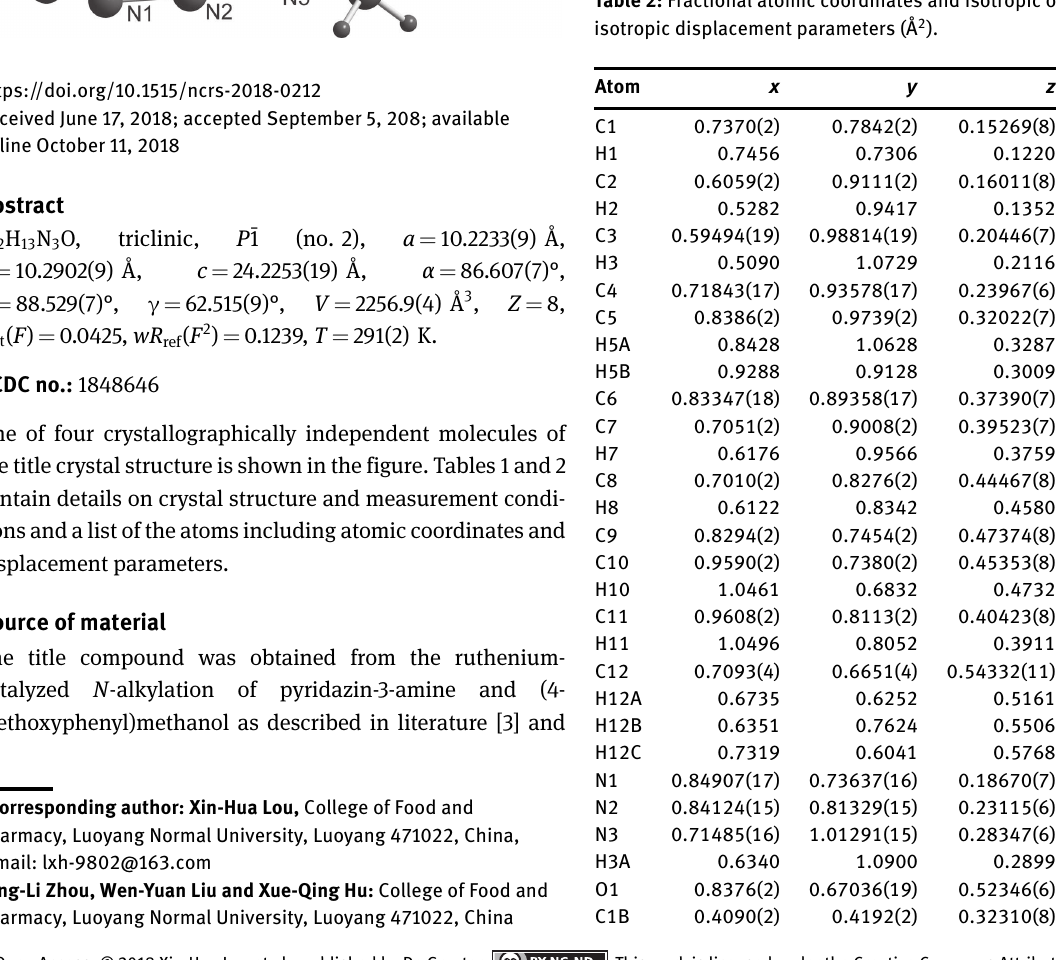
Table 2: Fractional atomic coordinates and isotropic or equivalent isotropic displacement parameters (Å 2